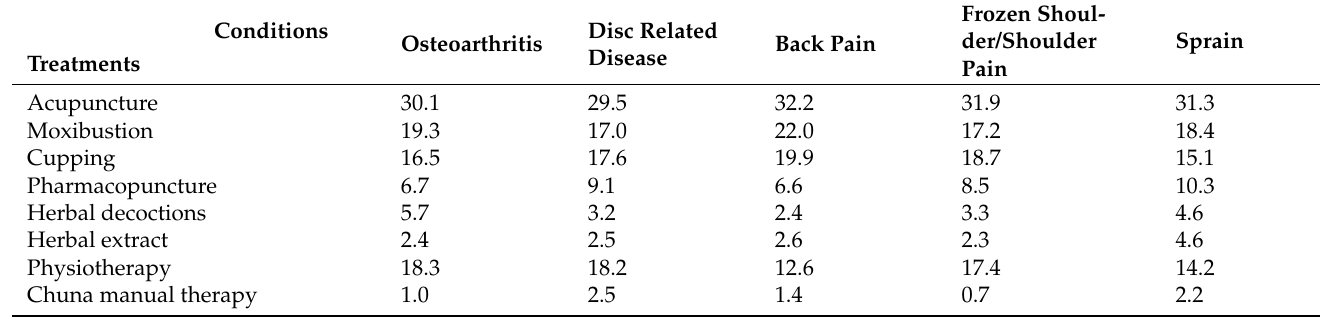
Table 4. Treatments used for the top five symptoms in the older outpatient group (Unit: